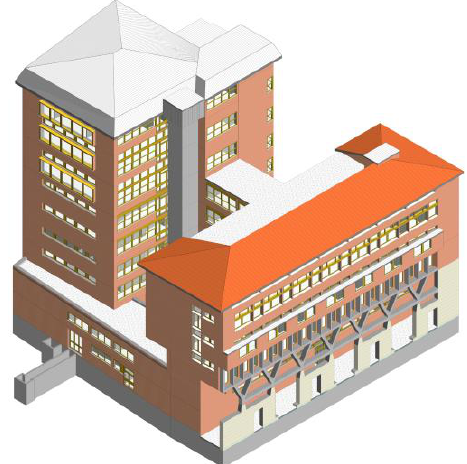
Figure 2. The HBIM model of the Institute of